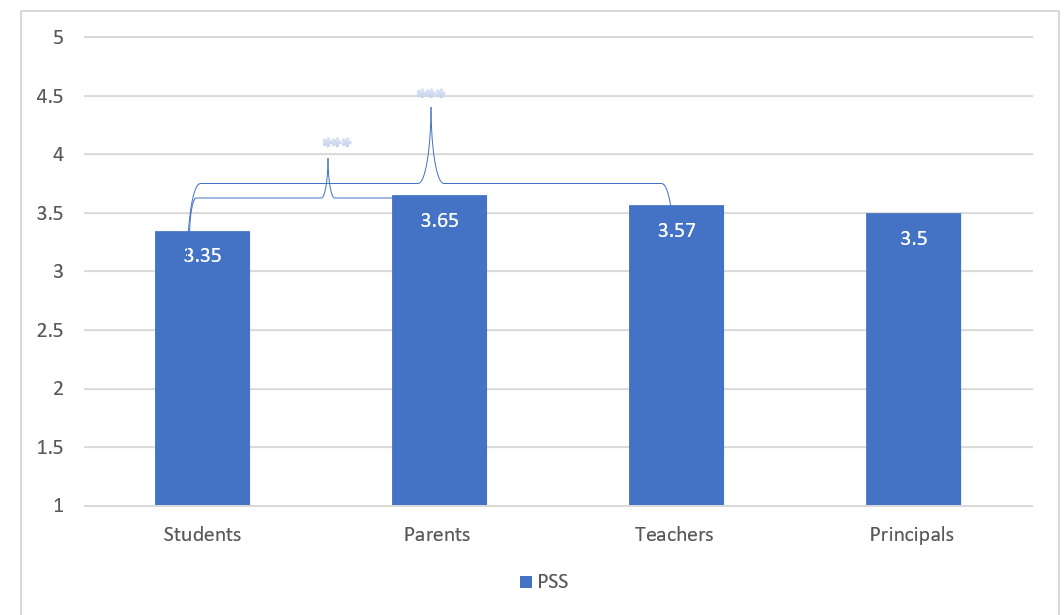
Figure 3. Perceived stress scale (PSS)-4 Index according to the four stakeholders (Students, Parents, Teachers, Principals). Note: 1 = Higher PSS, 5 = Lower PSS. Statistical significance denoted as * ( p -value less than 0.05 (*); p -value less than 0.01 (**), p -value less than 0.001 (***) according to Bonferroni’s multiple comparisons test.